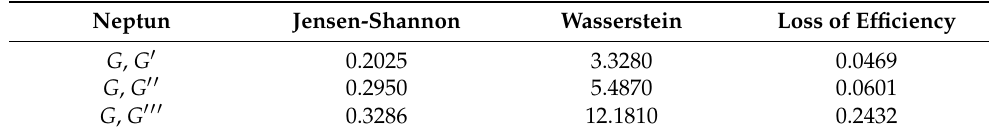
Table 3. Probabilistic distances vs. loss of efficiency.